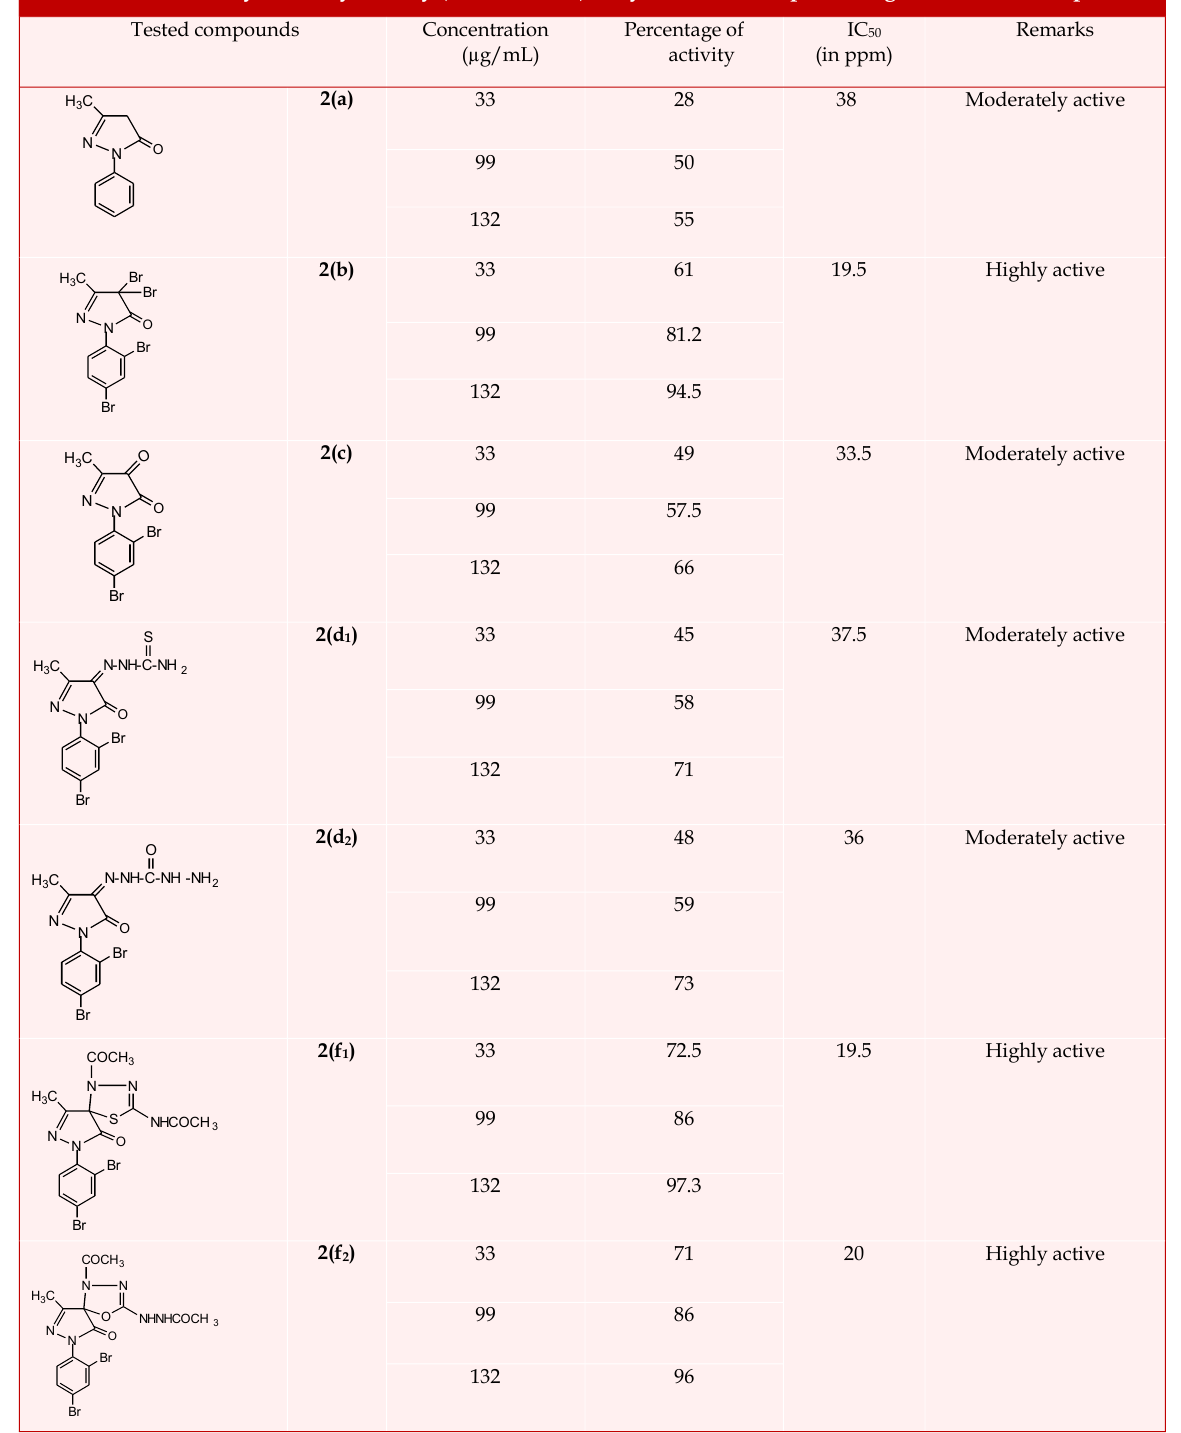
ppm in that order, were moderately active.